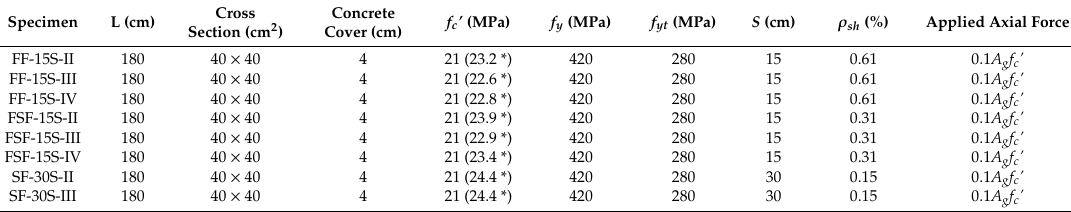
Table 1. Design details of each column specimen.